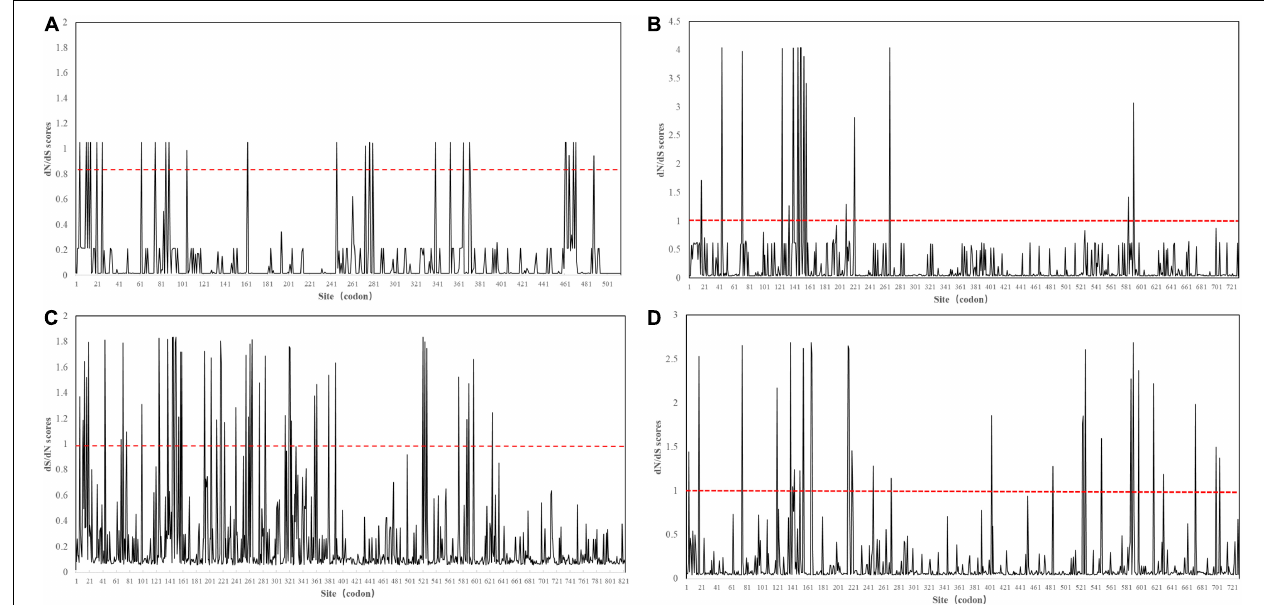
FIGURE 3 | Sliding window analysis of S1 amino acid sites within each lineage. The red dotted line represents the critical value of dN/dS = 1. (A) FCoV-I. (B) FCoV-II. (C) CCoV-IIa. (D) CCoV-IIb.